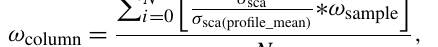
ground-based AERONET at multiple sites over southern Africa, the SSA with a mean difference of 0.01 (rms: 0.03) in biomass burning aerosol measurements (Leahy et al.,